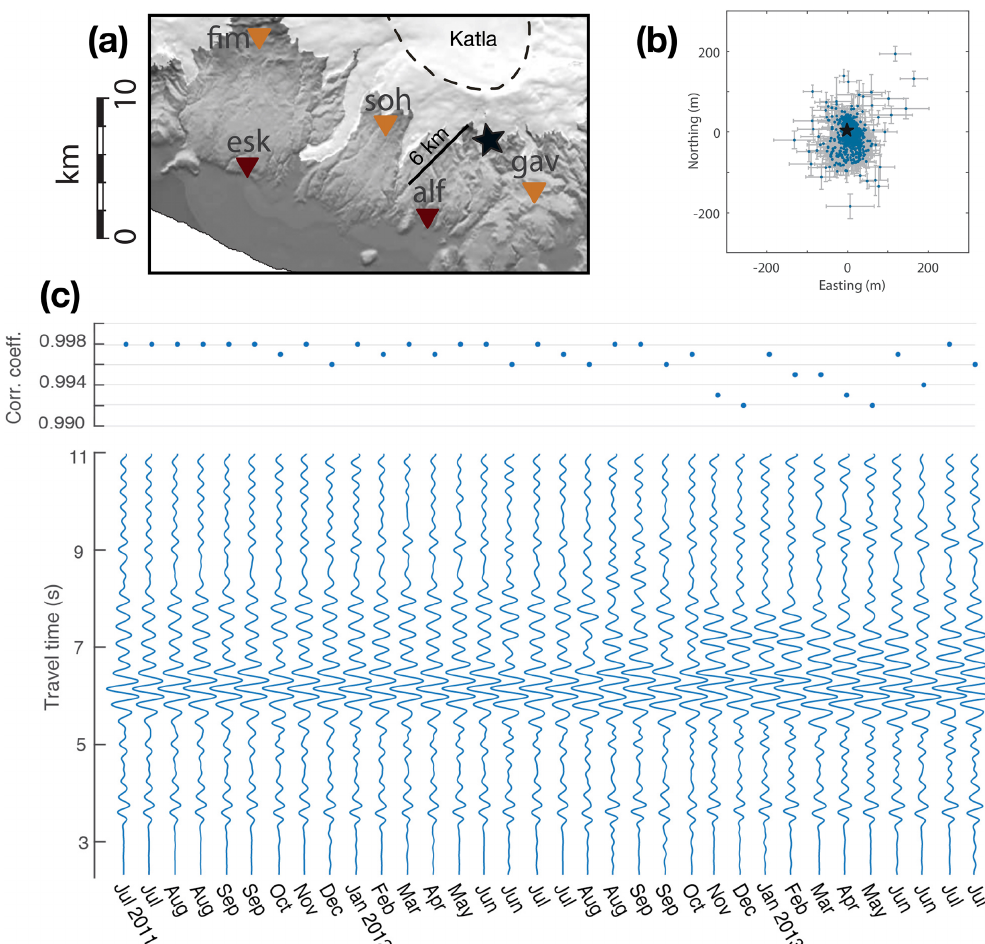
Figure B1. (a) Map of the southern flank of Katla volcano (Iceland; topography information from the National Land Survey of Iceland). The caldera rim is outlined by the black dashed line. White areas are glaciers. The star marks the location of the seismic cluster. Dark brown triangles: permanent Icelandic Meteorological Office (IMO) seismic stations. Orange triangles: temporary Uppsala University seismic stations operating between May 2011 and August 2013. (b) Relative locations (blue points) and uncertainties ( ± std; grey lines) from Sgattoni et al. (2016a) (c) Example waveforms of the Z component recorded at station ALF throughout the entire period investigated and correlation coefficients of the P waves with respect to the master event used for the relative locations shown in (b) . Panels (a) and (b) have been modified from Sgattoni et al. (2016a). Panel (c) has been modified from Sgattoni et al.